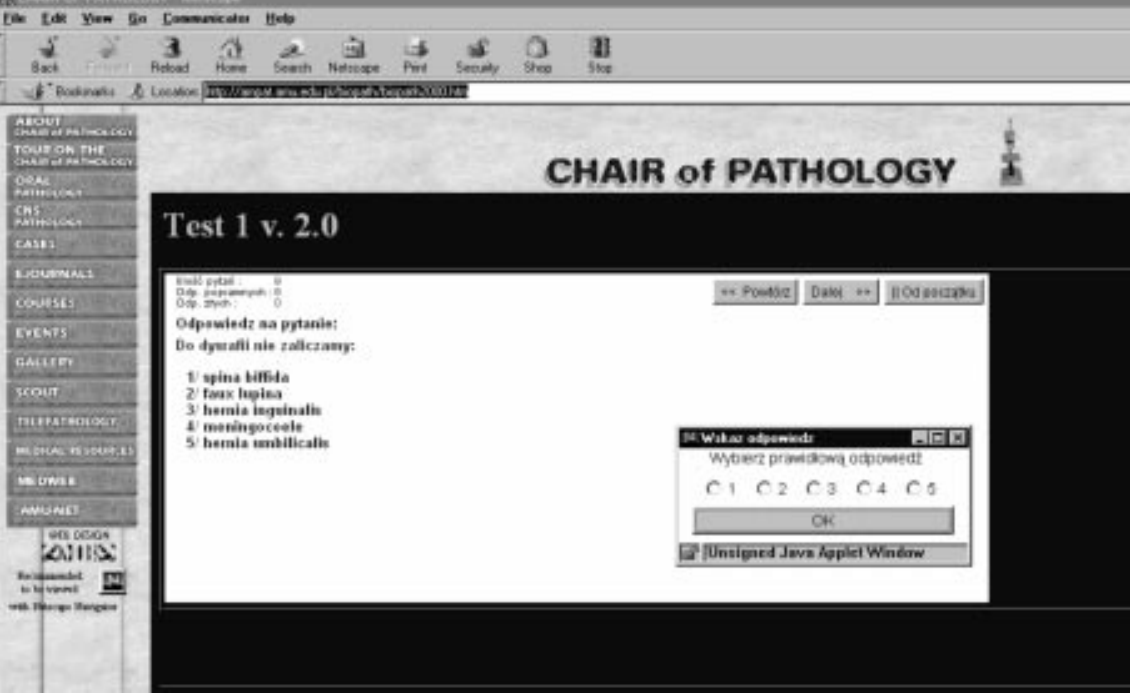
Fig. 6. Implementation of EXAMINATOR program on the WWW server for self-testing, available through the